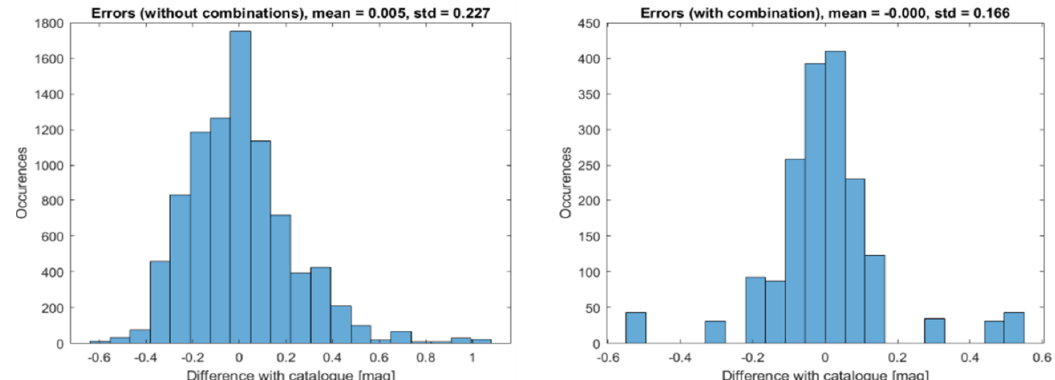
Figure 5. Errors mean and standard deviation without stars combination ( left ) and with stars combination ( right ).